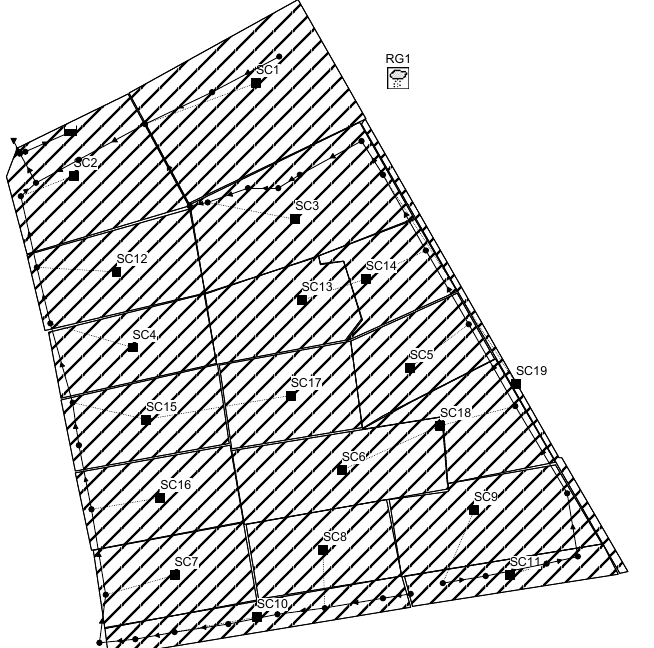
Figure 4. Model layouts.